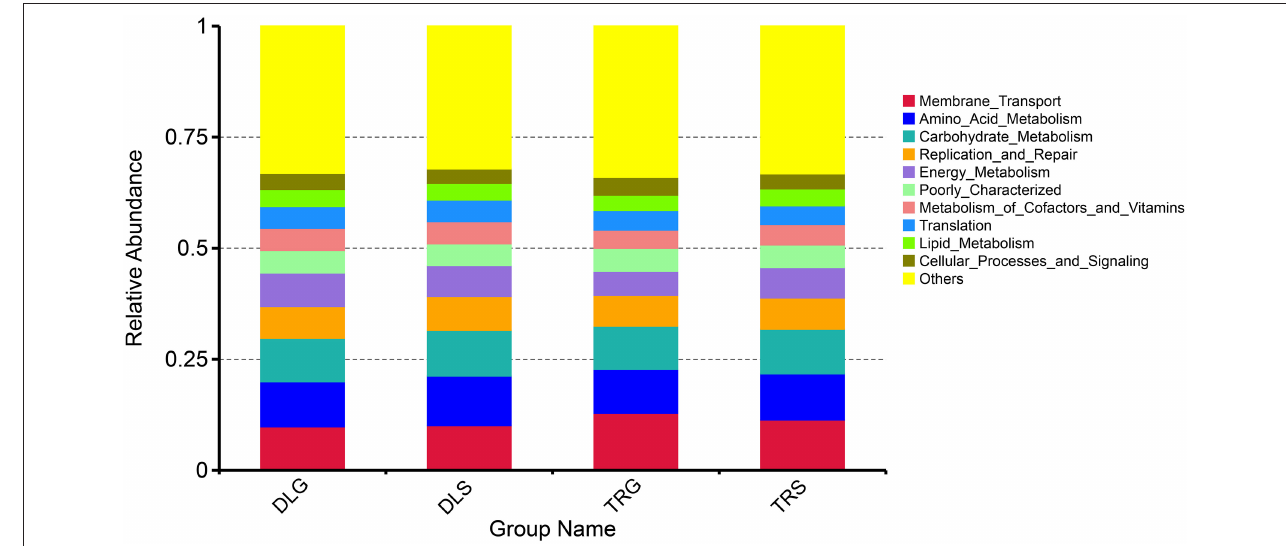
FIGURE 7 | The KEGG function prediction of the four